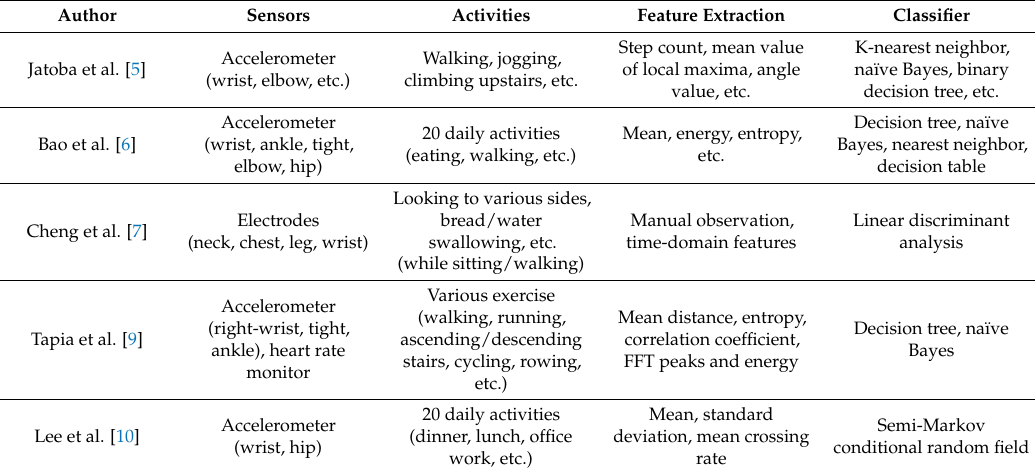
Table 3. Sensors, activities, and methods of daily activity recognition